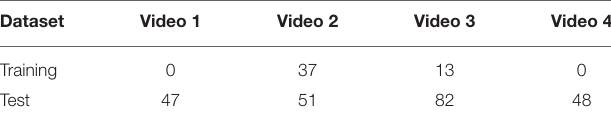
TABLE 2 | The fusion algorithm